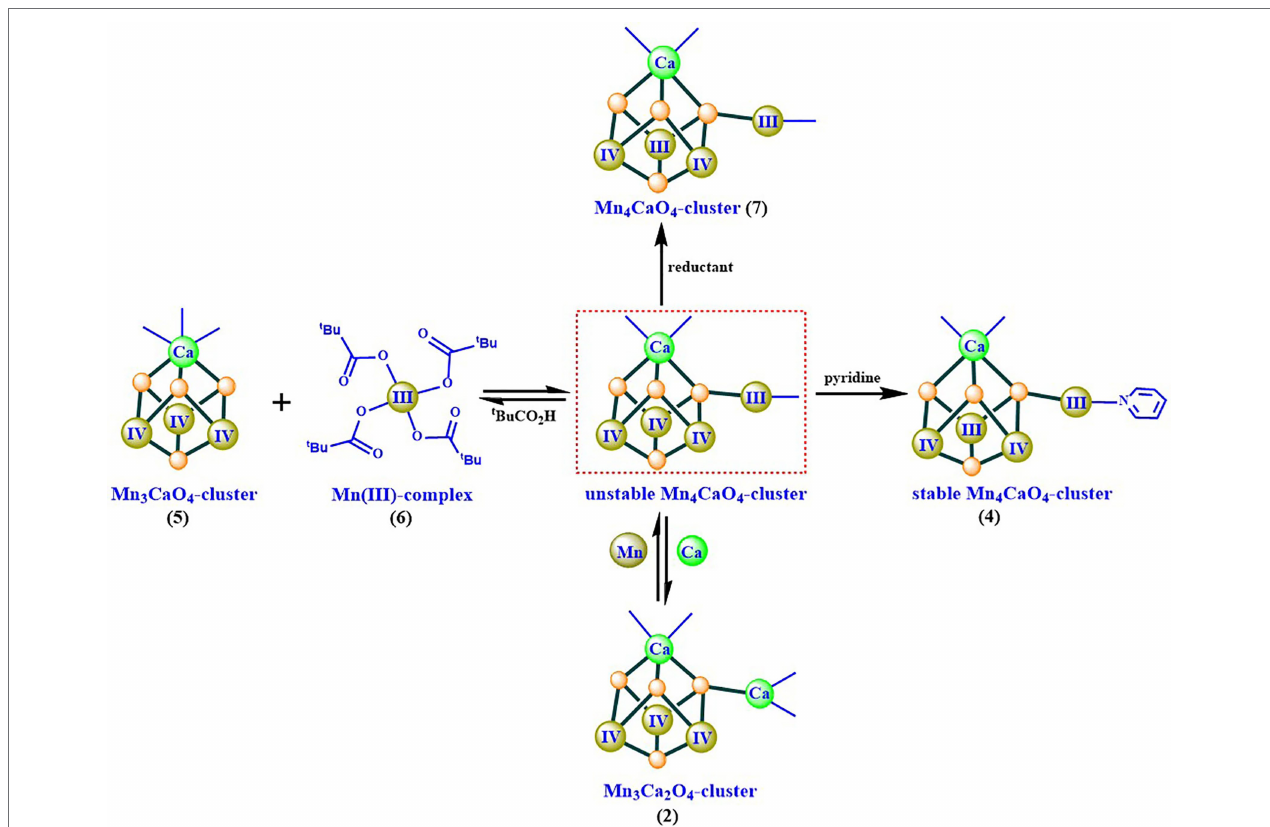
FIGURE 8 | Possible synthesizing mechanism of the artificial Mn 4 CaO 4 -cluster ( 4 ) (Chen et al.,